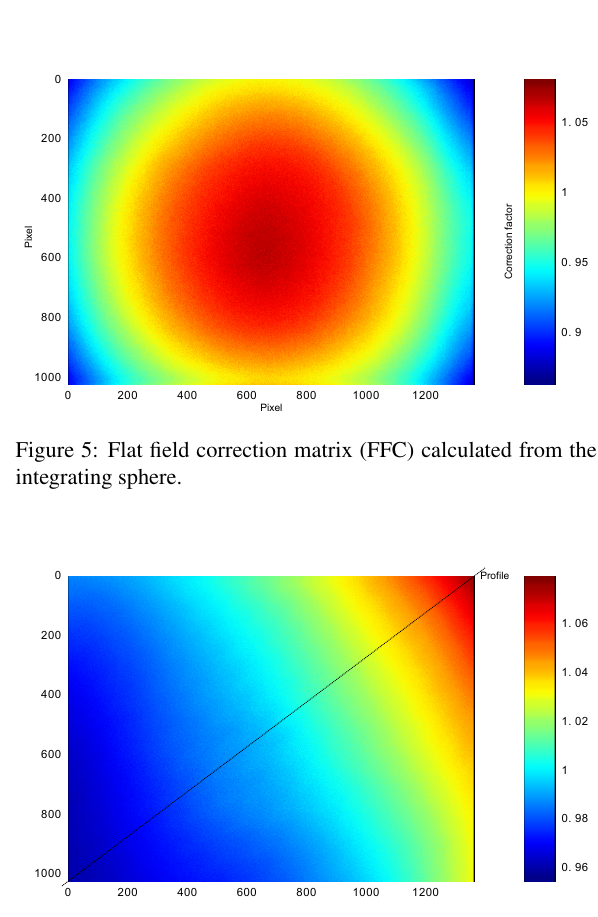
Figure 6: Inhomogeneity of the LED backlight, with profile line.